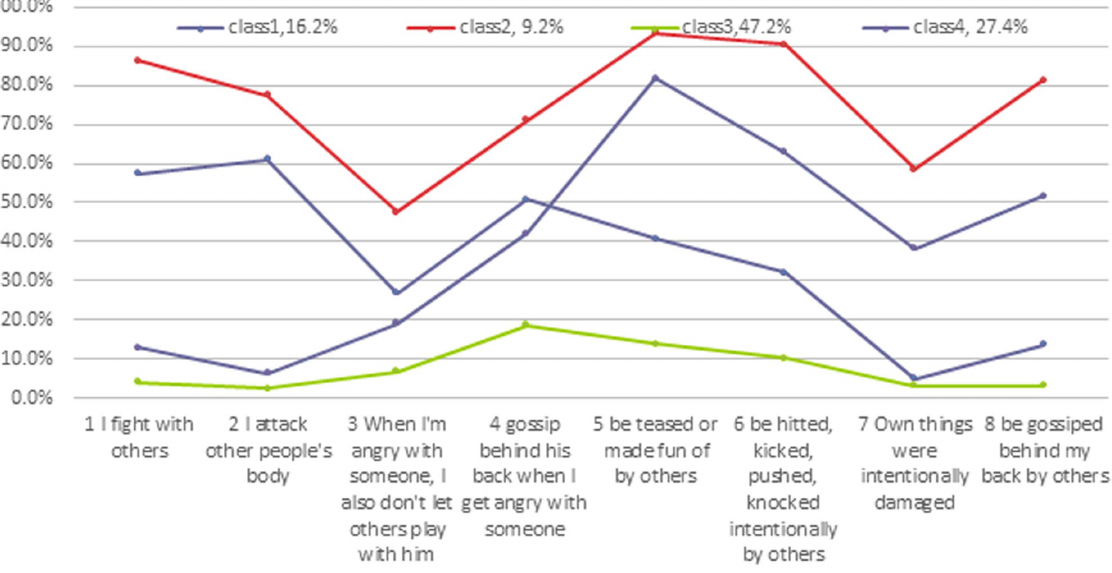
Figure 1. Profile plots for the four-class model. The x-axis is four aggression and four victimization items, and the y-axis the probability of endorsing the items.